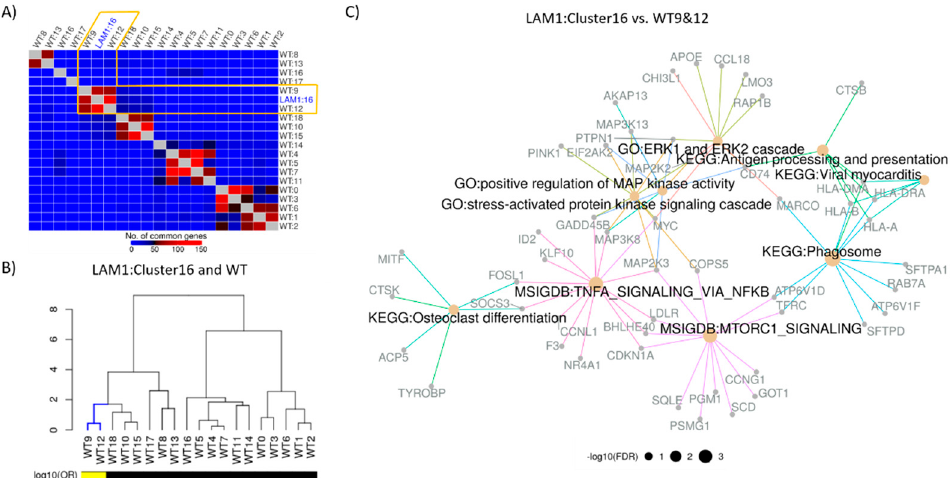
Figure 2. Construction and functional enrichment of disease characterizing signature. ( A ) WT clusters were matched with the LAM cluster in terms of top 200 most significantly (FDR < 0.05) up-regulated genes from each of the CAS. Unsupervised hierarchical clustering revealed sub-clusters of LAM and WT clusters, where LAM1 cluster16 was clustered with WT clusters 9 and 12. ( B ) Significance of the overlaps between LAM and WT cell clusters based on the significantly (FDR < 0.05) up-regulated genes were assessed via Fisher’s exact test. Cluster similarities were measured using log10 odds ratio and hierarchical clustering of LAM1 cluster16 vs. WT is visualized via dendrograms. Log 10 odds ratio (OR) of 1 or more is indicated by the yellow color. ( C ) Disease characterizing signatures of LAM were constructed by comparing LAM1 cluster16 with the WT cluster 9 and 12. Functional enrichment of top 200 most significantly (FDR < 0.05) up-regulated genes was carried out in terms of KEGG/MSigDB (Hallmark)/GO (Biological processes) categories. Selected functional classes based on the cutoff of FDR adjusted p -values < 0.1 are represented by different edge colors and size of the node is proportional to negative logarithm of FDR adjusted p − value. The pathway analysis of the LAM single-cell DCS against GO [18], KEGG [19], and MSigDB (Hallmark) [20] gene sets with clusterProfiler [21] implicated MTORC1 signaling hallmark gene sets as being enriched in the DCS (Figure 2C), along with gene sets and pathways associated with cell proliferation, invasion, and metastasis. Although most of these signaling pathways are known features of LAM, identifying their activity within the LAM cell populations based on a transcriptional signature is not a trivial task. The analysis of the pseudo-bulk LAM signature does not reveal increased MTOR signaling (Supple- mentary Figure S4A), demonstrating the critical increase in precision of our DCS in com- parison to a typical signature constructed from bulk tissue profiling. 2.5. Connectivity Analysis We developed methods for CMaP analysis of DCS’s with the aim of identifying the Mechanism of Action (MOA) of bioactive compounds capable of reversing the LAM. The single-cell DCS is first correlated with correlated with 143,374 LINCS signatures in re- sponse of 15,349 chemical perturbagens (CP) (Figure 3A). The enrichment of signature with high negative correlations among CPs with a specific MOA was then assessed using small-sample bias corrected logistic regression (technical details in Methods). In the CMaP analysis of LAM1 DCS, most enriched MOA categories included MTOR inhibitors, dual inhibition of PI3K/MTOR, and CDK inhibitors (Figure 3B,C, and Supple- mentary Table S3). Given the known etiology of LAM, and the use of the sirolimus MTOR inhibitor in the treatment of LAM, ability of MTOR inhibitors to reverse the LAM was expected and also in line with the functional analysis results from the previous section. However, the same connectivity analysis repeated on the pseudo-bulk LAM signature failed to identify MTOR inhibitors as putative therapeutics (Supplementary Table S5).